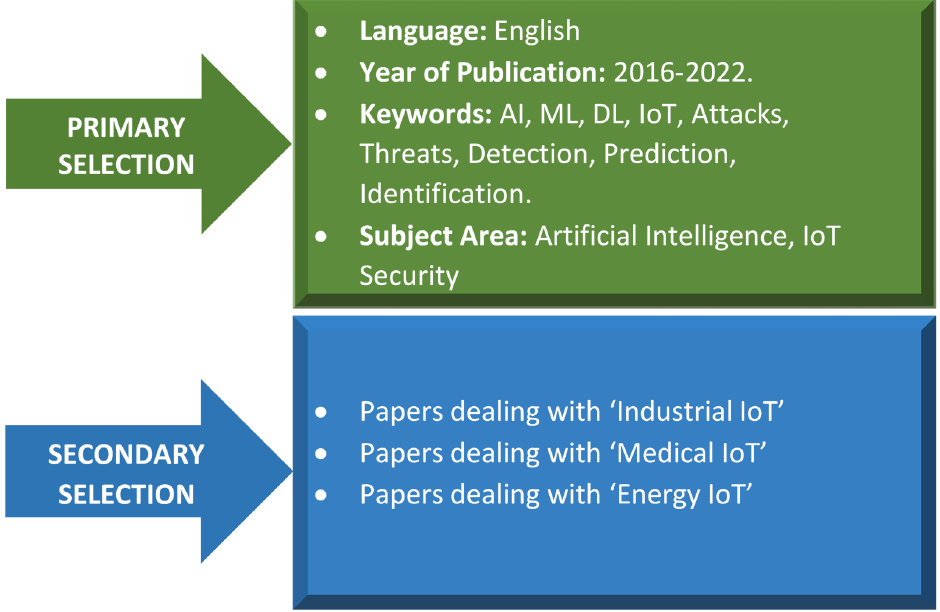
Figure 2. Paper selection